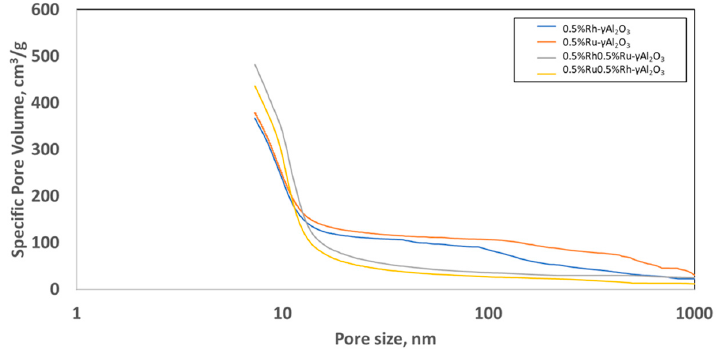
Figure 1. Specific pore volume vs. pore size for the catalytic samples from the Hg intrusion porosimetry.